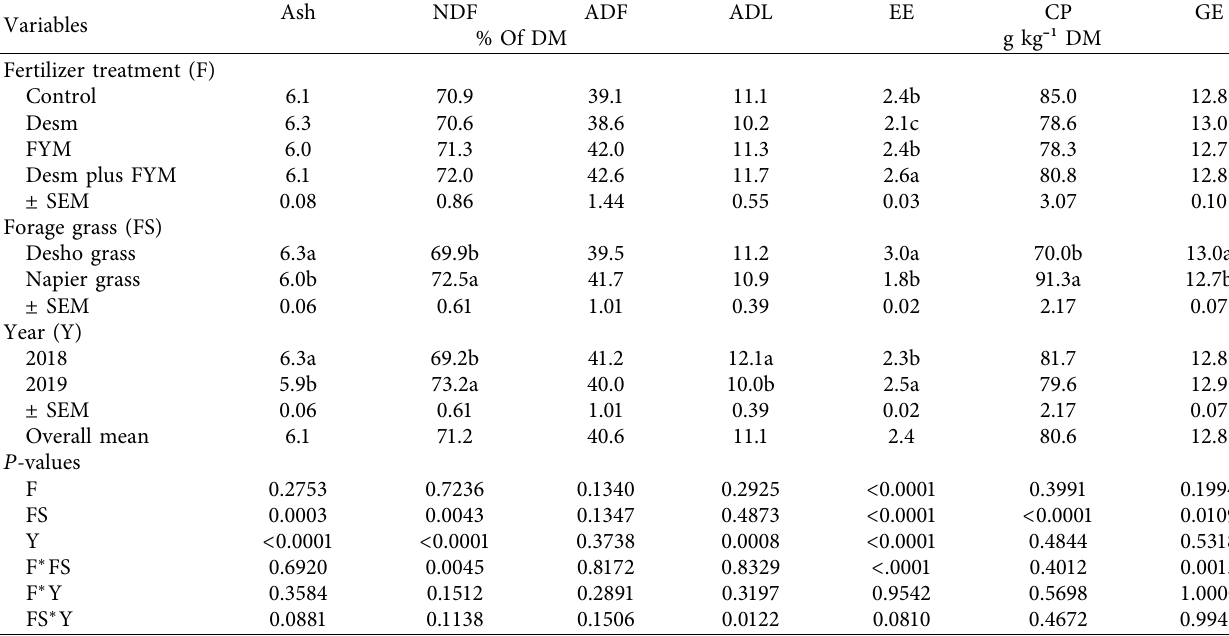
Table 1: Effects of fertilizer treatments on the chemical composition of forage grasses at the Aba Gerima watershed. Variables Fertilizer treatment (F) Control